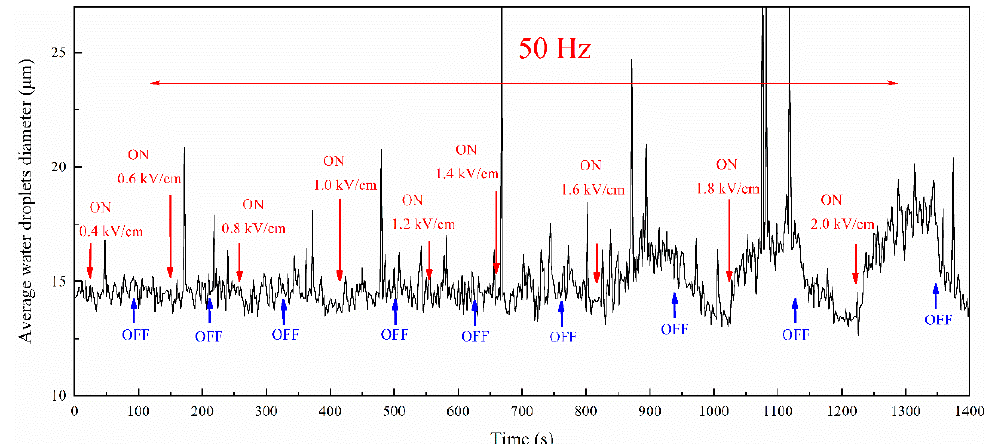
Figure 24. Variations of average water droplet size with parallel plate electrode.